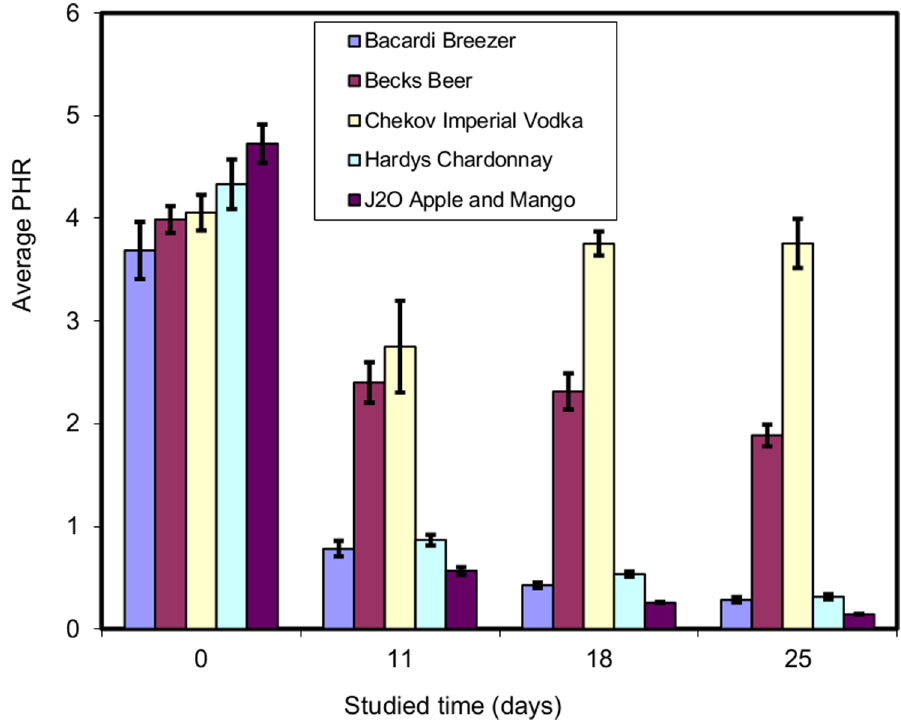
Figure 3. Peak height ratio (PHR) of silylated temazepam: diazepam -d 5 (n=3).